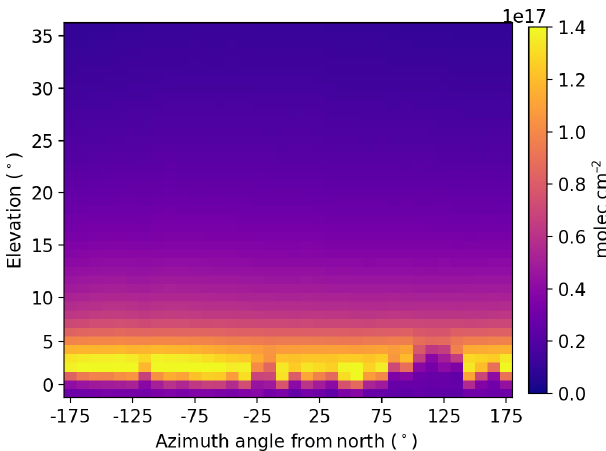
Figure 8. Color-coded NO 2 DSCDs (average of 16–24 Septem- ber 2016) as a function of azimuth angle on the x axis (N = 0 ◦ , E = 90 ◦ , S = 180 ◦ , or − 180 ◦ , W =− 90 ◦ ) and elevation angle on the y